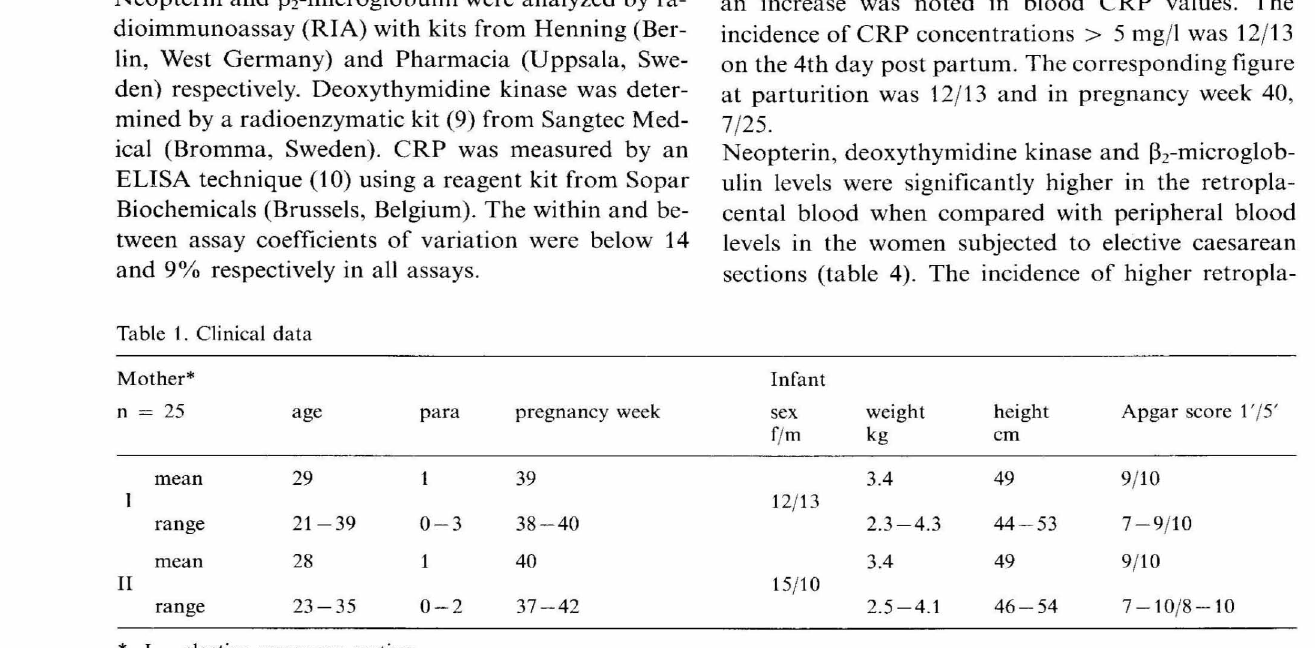
Table 2. Serum levels of neopterin, CRP, deoxythymidine kinase and ~rmicroglobulin in pregnancy week 20 and